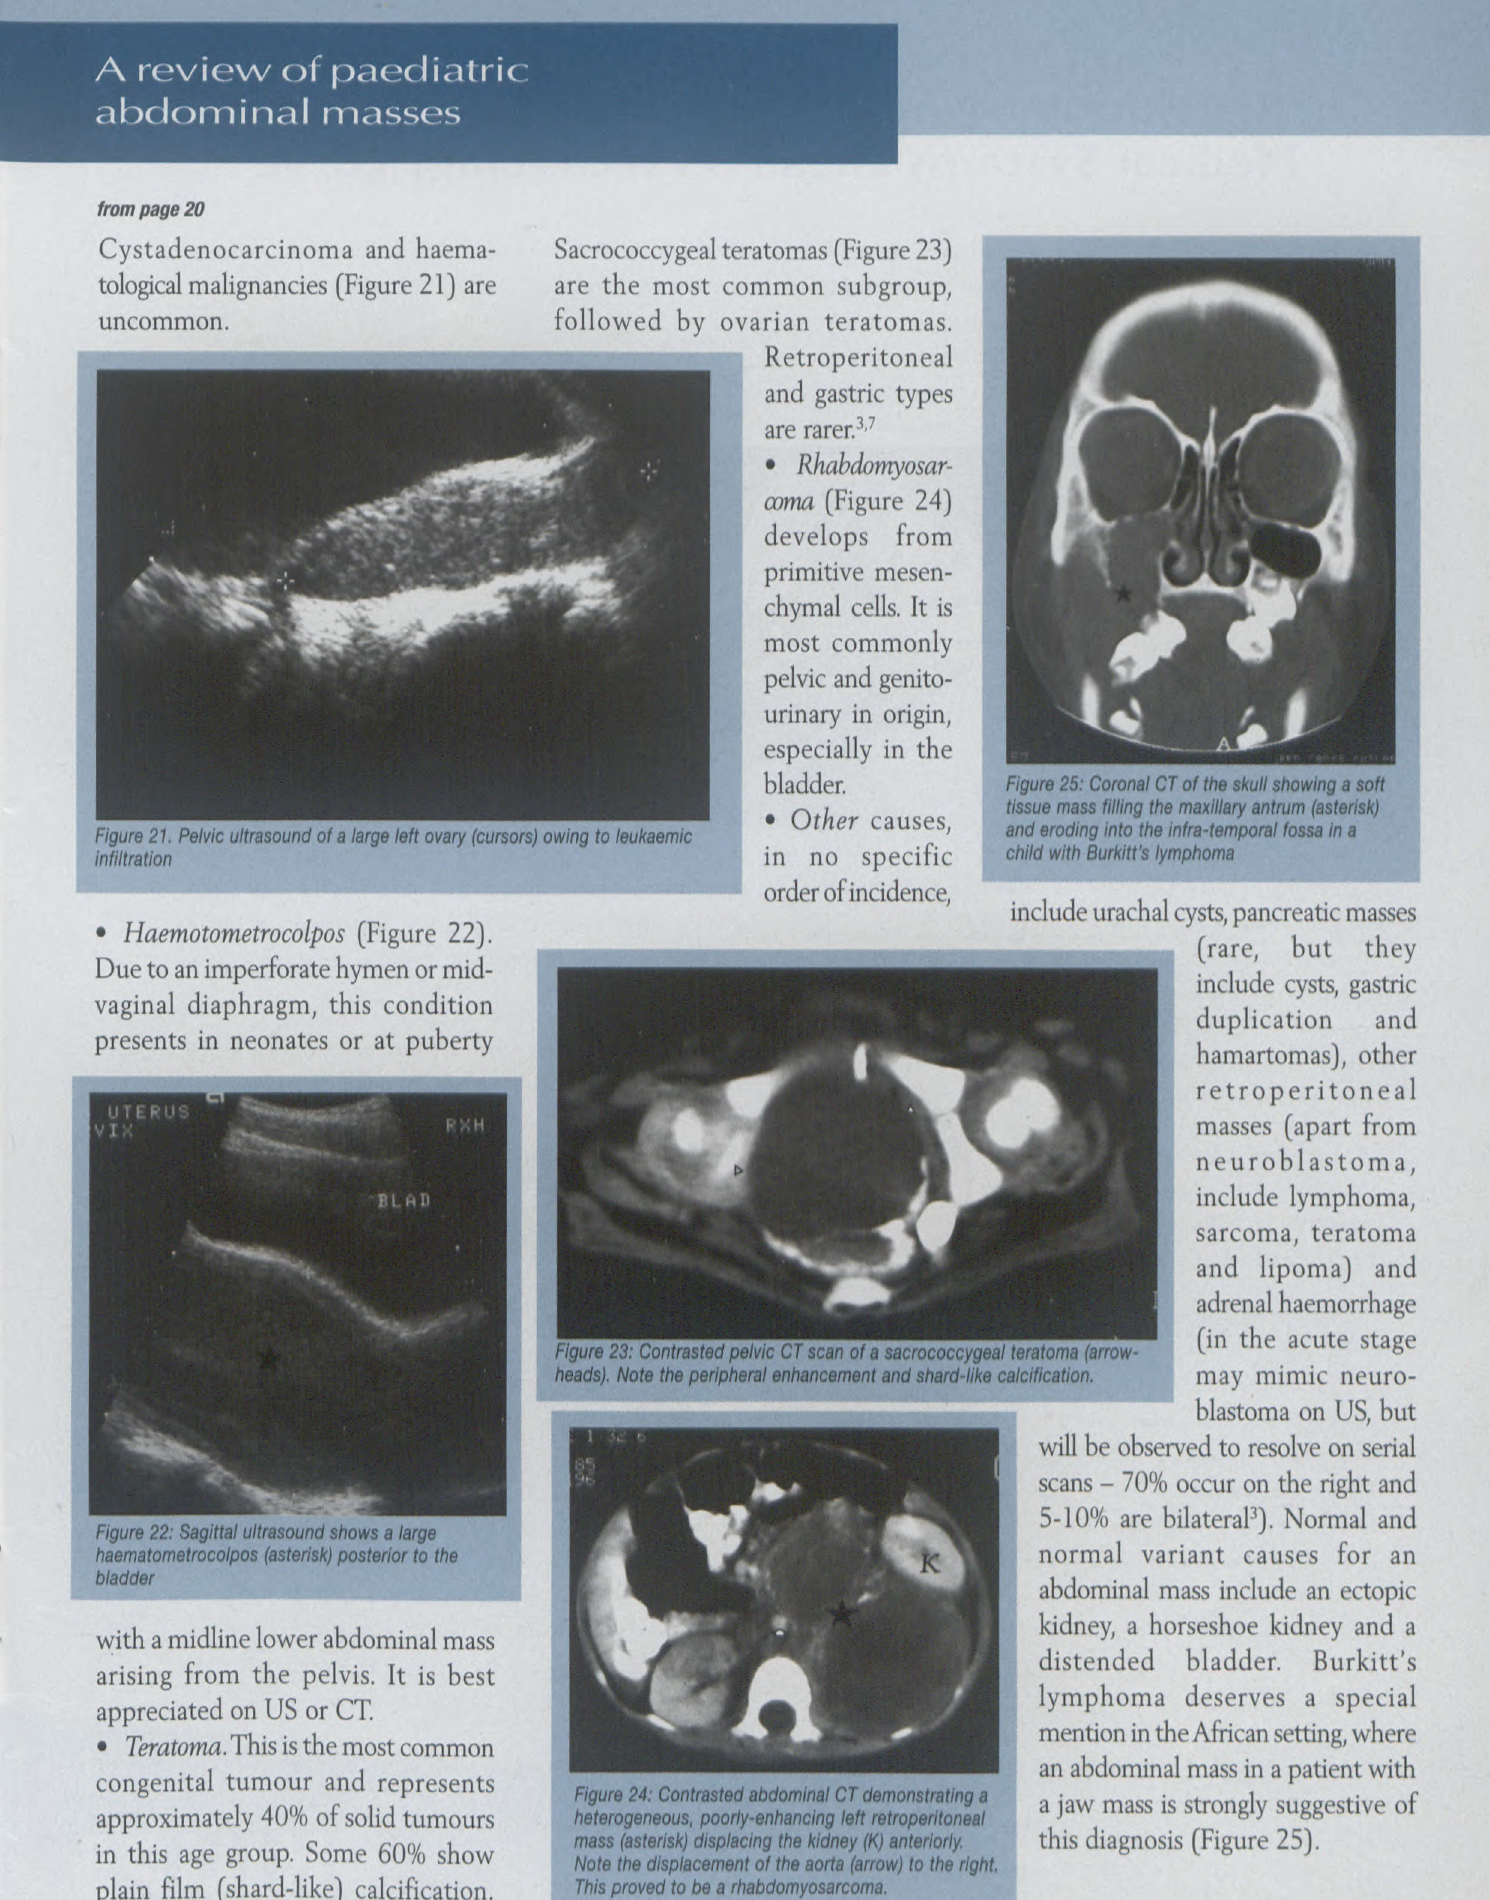
Figure 24: Contrasted abdominal CT demonstrating a heterogeneous, poorly-enhancing left retroperitoneal mass (asterisk) displacing the kidney (K) anteriorly. Note the displacement of the aorta (arrow) to the right. This proved to be a